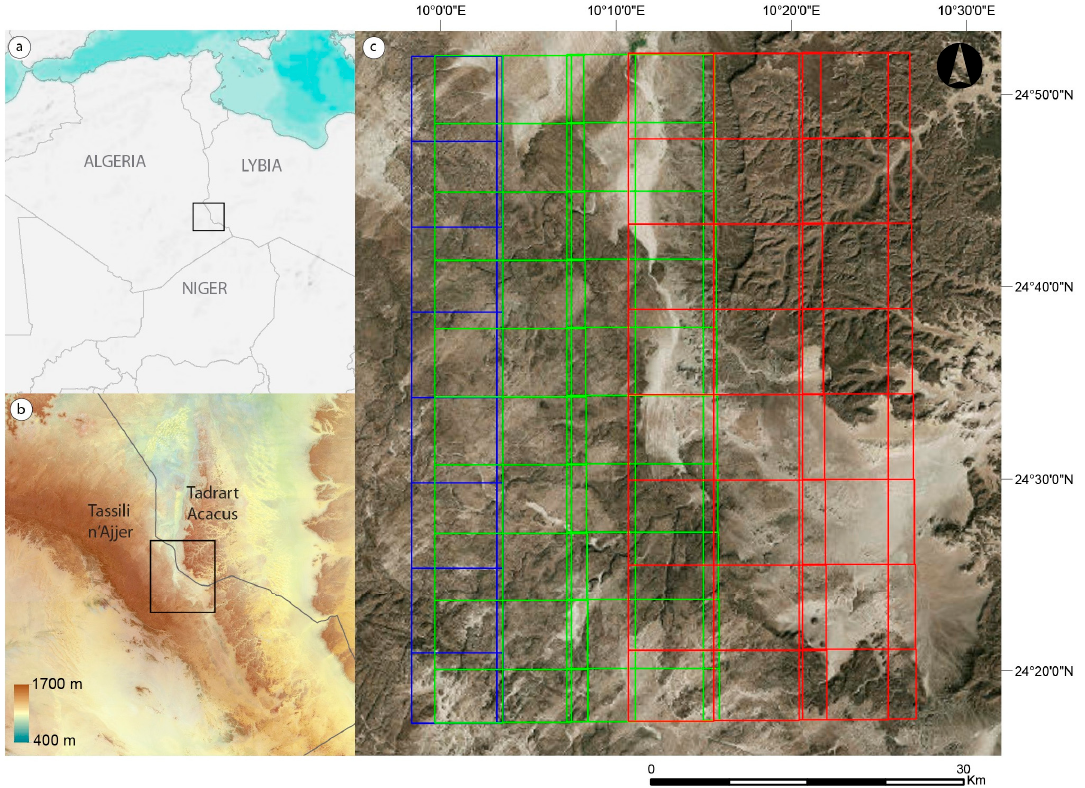
Figure 2. Details of the study area. ( a ) Geopolitical setting (base map: ESRI); ( b ) Digital Elevation Model (DEM) at a spatial resolution of 1 arc-second (30 m) overlain with the area of interest (black polygon, which includes parts of the Tassili n’Ajjer and the Tadrart Acacus). SRTM data courtesy of the United States Geological Survey (USGS, 2014, base map: SRTM v4.1, www.cgiar-csi.org); ( c ) detail of the study area boxed in ( b ) featuring the WorldView (WV) tiles used for mapping purposes (blue: WV1, red: WV2, green: WV3); for the characteristics of the WV imagery, see Section